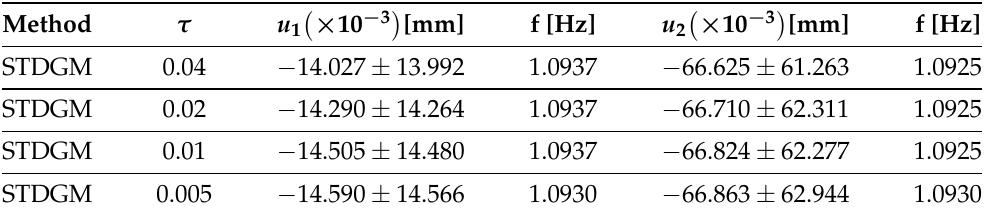
Table 2. Comparison of the position of point A for the STDGM with decreasing time step τ for the neo-Hookean model.